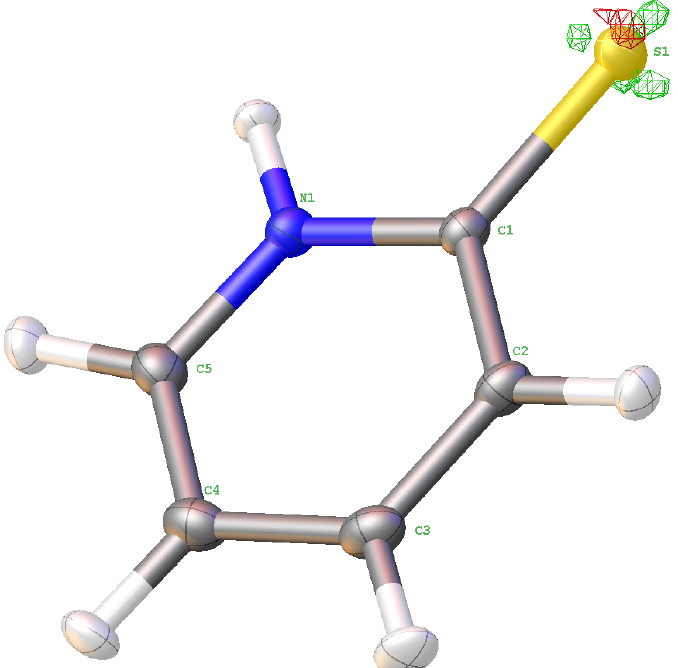
Figure 7. Difference electron density in (I) . Contour level 0.217 e/Å 3 . Positive contours are drawn in green, negative in red. Calculated structure factors are taken from the non-spherical atom model refined with NoSpherA2 [10] in Olex2 [13]. Maximum resolution ( sin θ / λ ) max = 1.24 Å − 1 . Plot prepared with